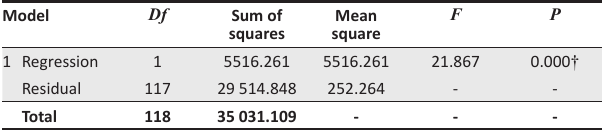
TABLE 8: Analysis of variance summary results for trait emotional intelligence by